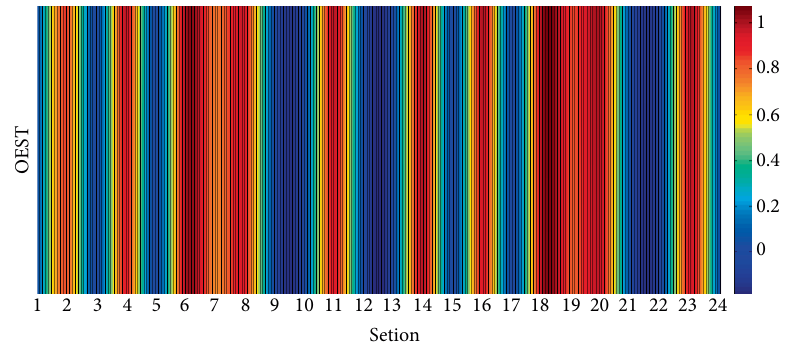
Figure 11: The regenerative braking energy utilization ratio in each section of the